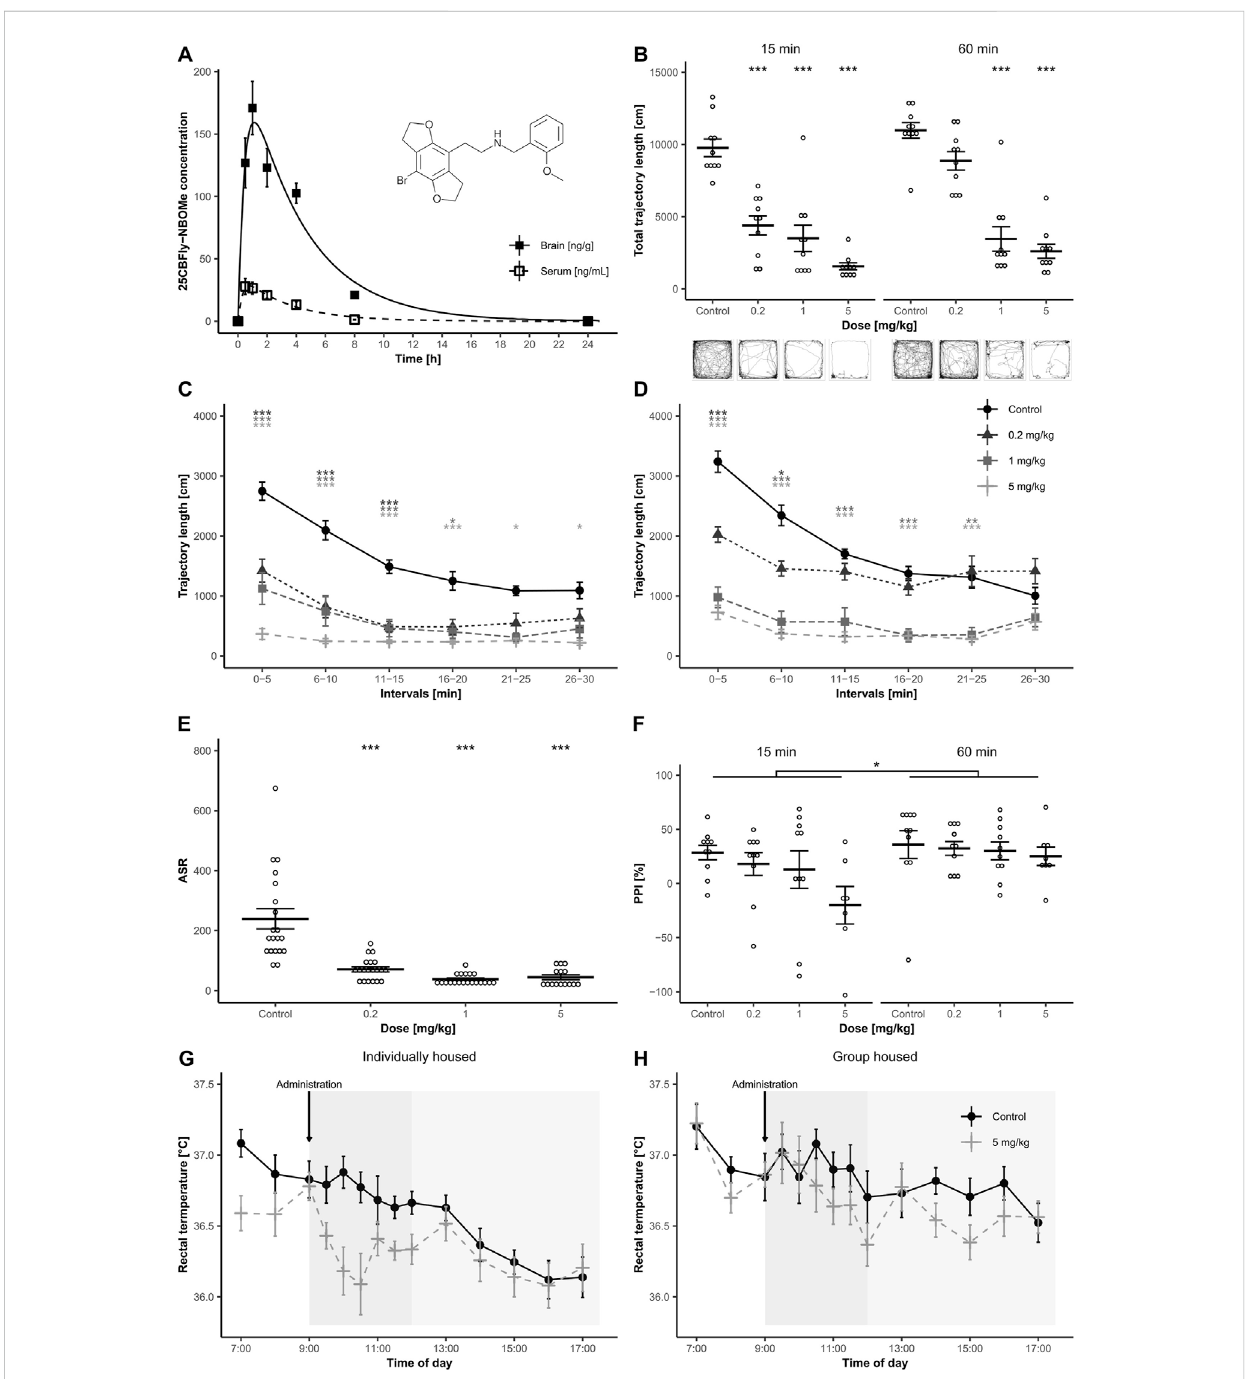
FIGURE 1 (A) Structure of 2C-B-Fly-NBOMe and graph of mean 2C-B-Fly-NBOMe concentration (1 mg/kg s. c.) in serum and brain over 24 h (n = 8 per time point).Errorbarsdisplay±1standarderrorofthemean(SEM). (B) Totallocomotionmeasured15and60 minafter2C-B-Fly-NBOMe(0.2,1and5 mg/kgs. c.) or ctrl administration (n = 10). Error bars display ±1 SEM, asterisks indicate signi fi cant differences from the ctrl group (* p < 0.05, ** p < 0.01, *** p < 0.001). Picture inserts below demonstrate trajectory patterns induced by the drug treatment. (C,D) : Means of trajectory length within 5 min blocks 15 min (C) and60 min (D) afteradministrationof2C-B-Fly-NBOMe(0.2,1and5 mg/kgs.c.)orctrl.Errorbarsdisplay±1SEM,asterisksindicatesigni fi cant differences from ctrl (* p < 0.05, ** p < 0.01, *** p < 0.001). (E) Mean effect of 2C-B-Fly-NBOMe (0.2, 1 and 5 mg/kg s. c.) on ASR (n = 7 – 10). Error bars display±1SEM,asterisksindicatesigni fi cantdifferencesfromctrl(* p < 0.05,** p < 0.01,*** p < 0.001). (F) ComparisonofmeanPPIofASRvaluesof2C-B- Fly-NBOMe (0.2, 1 and 5 mg/kg s. c.) and ctrl in 15 min (A) and 60 min (B) temporal onset (n = 7 – 10). Error bars display ±1 SEM, asterisks indicate signi fi cantdifferencesfromthectrl(* p < 0.05,** p < 0.01,*** p < 0.001). (G,H) :Theeffectof2C-B-Fly-NBOMe(5 mg/kgs.c.)onmeanrectaltemperature ( ° C) of individually housed animals (G) and 5 animals (H) per cage (n = 10). 2C-B-Fly-NBOMe or ctrl were administered at 09:00 h. Error bars display ±1